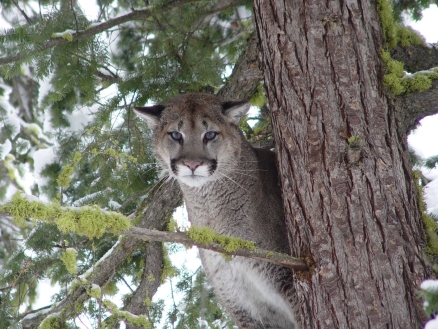
Echoes of the Past: Cougars Face the Same Threats Today That Nearly Eliminated the Species 100 Years AgoThe cougar, Puma concolor, once the most widely distributed carnivore in the United States, was extirpated east of the Mississippi River by the early 1900s, save for a remnant population in Florida, which now struggles to survive with fewer than 90 individuals. Habitat destruction and persecution, the same forces that eradicated the cat from the East, continue to threaten the existing populations in the West. (Rich Beausoleil, WDFW)